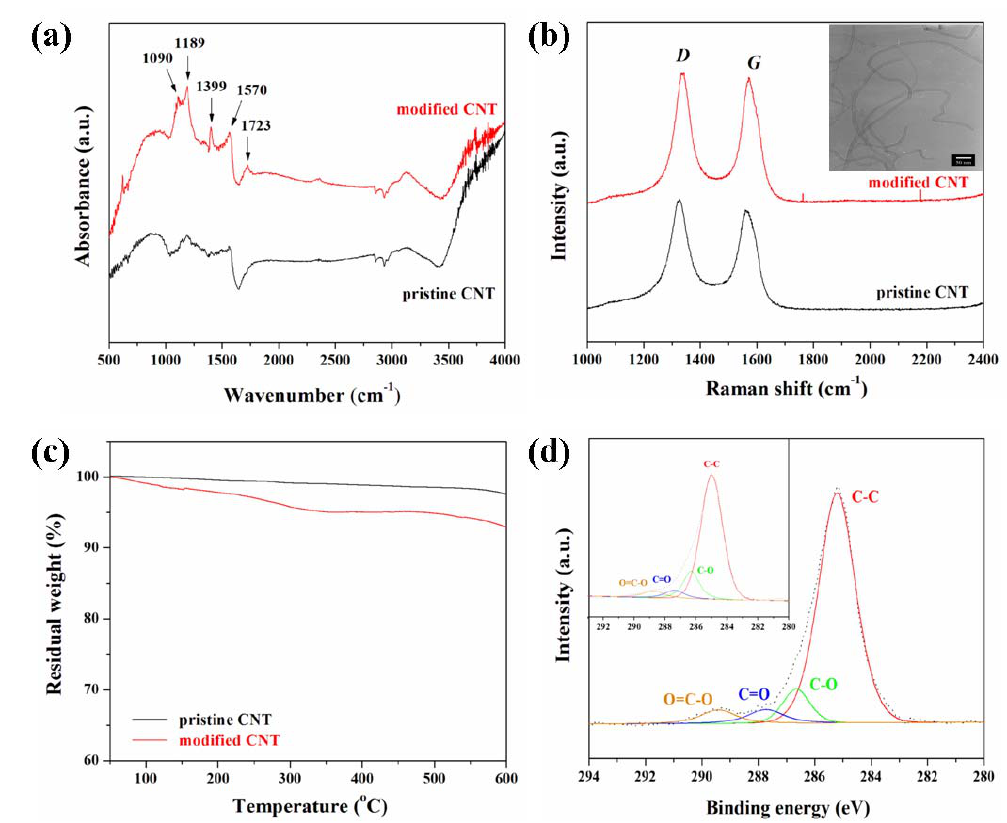
Figure 1. Characterization of modified CNT and TLCP nanocomposites. (a) FT-IR spectra of pristine and modified CNT. (b) Raman spectra of pristine and modified CNT. The / I ) of modified CNT decrease in the relative intensity ratio of G -band to D -band ( I G D indicates the increase in the degree of disorder and the presence of the defects on the surface of modified CNT by chemical modification. The inset shows TEM image of modified CNT. (c) TGA thermograms of pristine and modified CNT under N . (d) High 2 resolution C XPS spectra of TLCP nanocomposite containing 1.5 wt% of modified CNT. 1s XPS spectra of neat TLCP. The shifting of The inset shows high resolution C 1s characteristic peaks indicates the interactions between modified CNT and TLCP macromolecular chains in TLCP nanocomposites. Reproduced with permission from